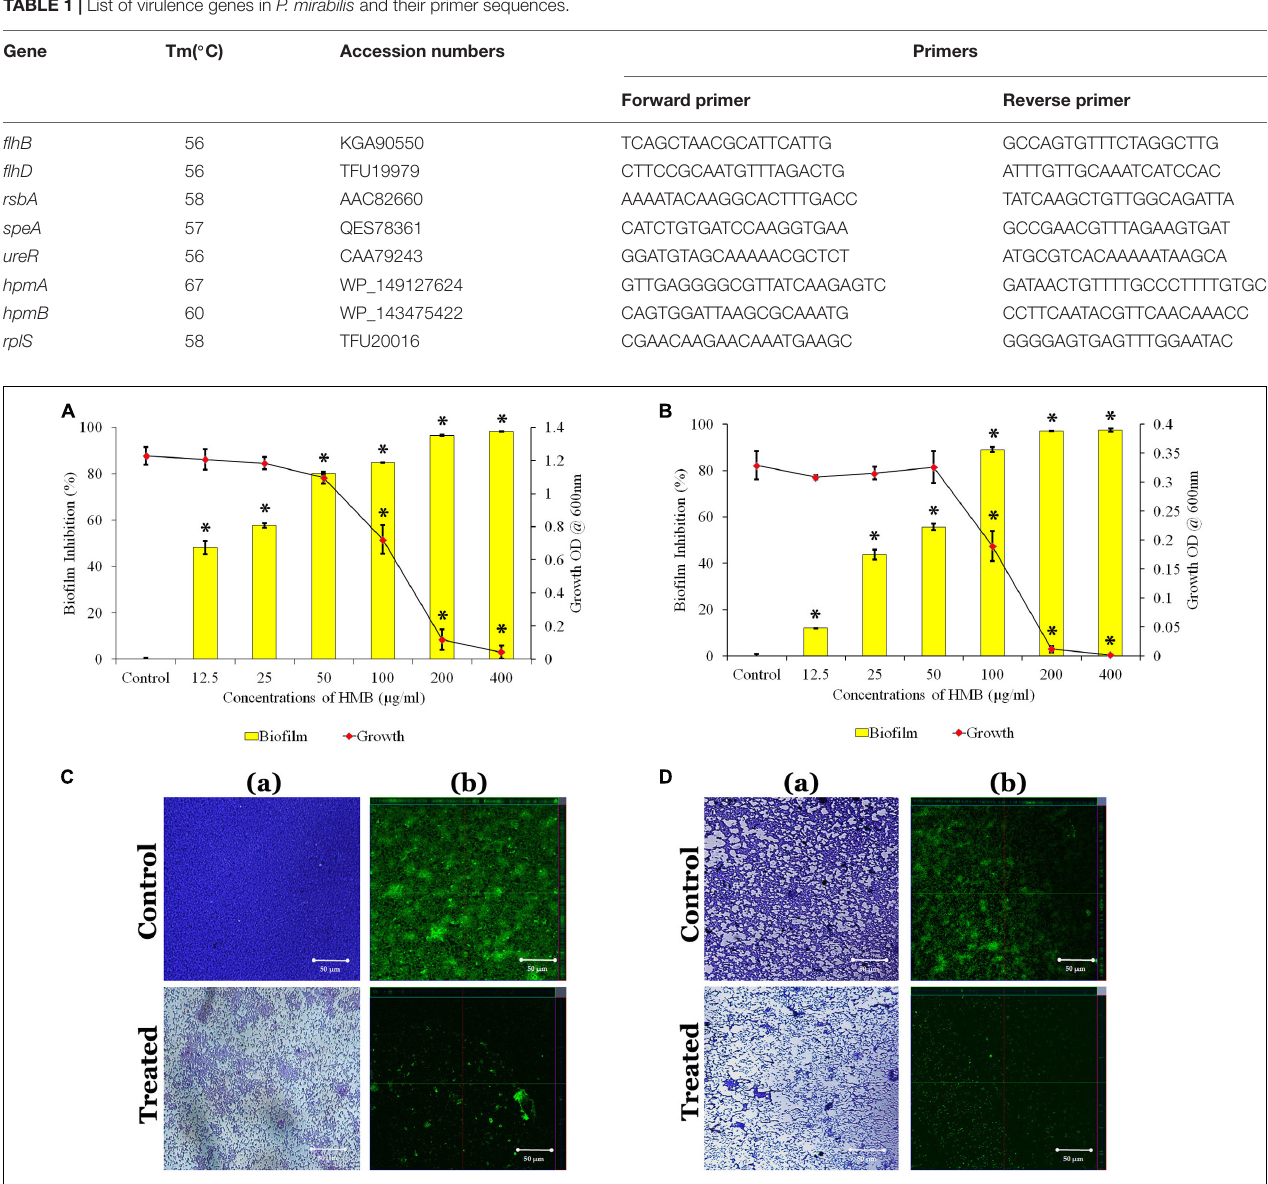
FIGURE 1 | Effect of HMB (at its MBIC) on growth and biofilm of Proteus mirabilis (A) ATCC and (B) CI. Data represent mean values ( n = 3) ± standard deviation. ∗ indicates significance at P < 0.005. Microscopic analysis of P. mirabilis (C) ATCC and (D) CI in the absence and presence of HMB at MBIC. (a) LM (400 × magnification) and (b) CLSM (scale bar = 50 µ m) images clearly portray a significant reduction in biofilm thickness of HMB (MBIC)-treated samples compared with untreated control. HMB, 2-hydroxy-4-methoxybenzaldehyde; MBIC, minimum biofilm inhibitory concentration; ATCC, American Type Culture Collection; CI, clinical isolate; LM, light microscopy; CLSM, confocal laser scanning